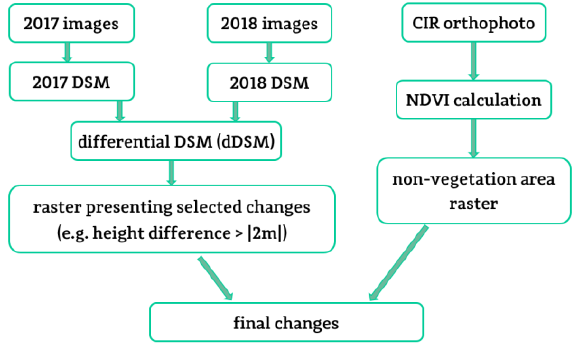
Figure 1. Methodology of land cover change detection based on DSM from DIM